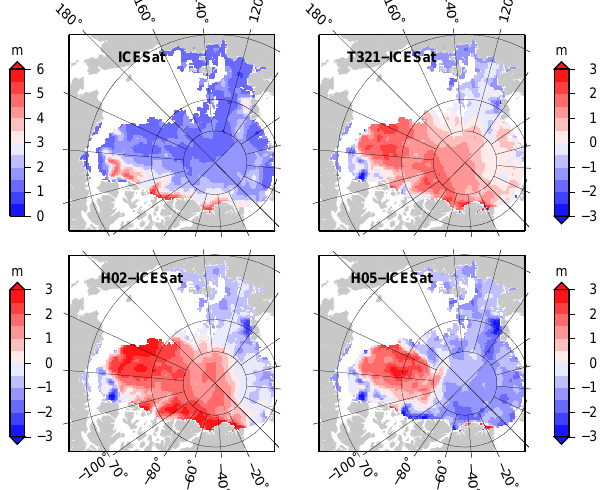
Figure 16. The mean ice thickness (in metres) for October– November 2007 from ICESat and the difference between ORCA12 T321 and CREG12 hindcasts H02 and H05 and the ICESat estimate.